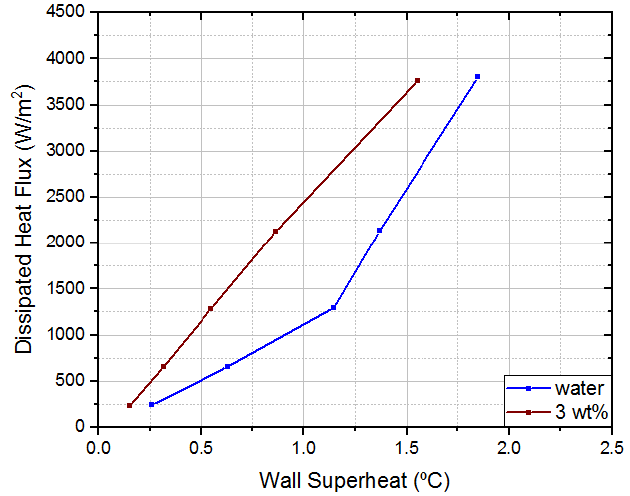
Figure 10. Wall superheat versus dissipated heat flux. Septuple superhydrophobic region with 1.5 mm diameter spots.